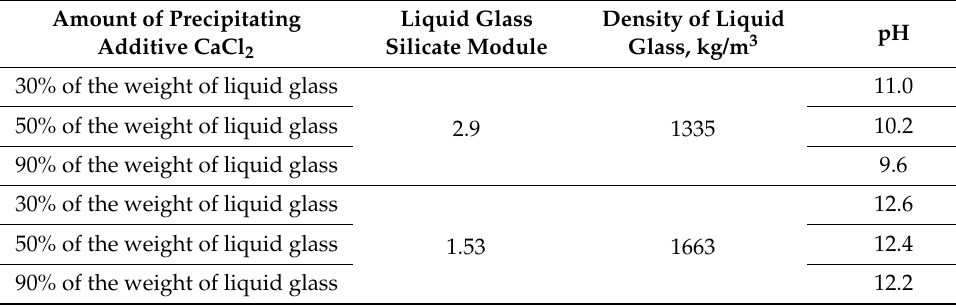
Table 4. Effect of precipitation conditions on the filler activity (specimens 015A).